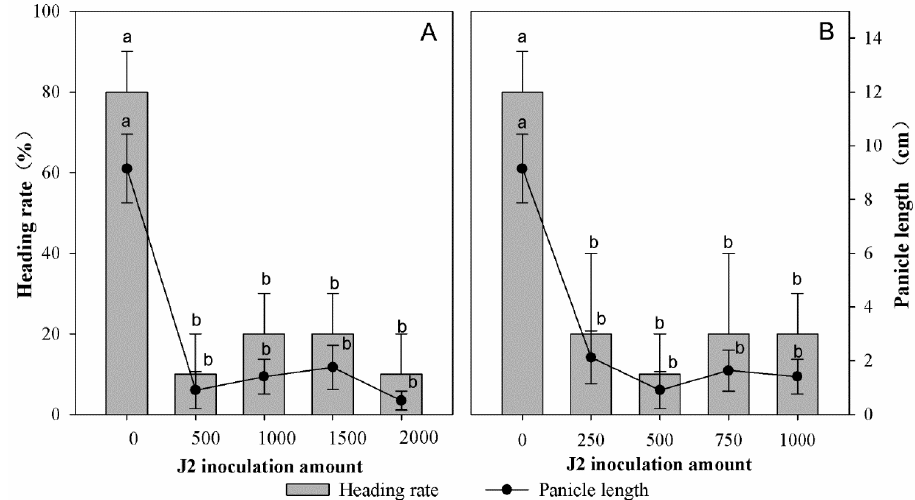
Figure 1. Effect of different inoculum densities of M. graminicola J2 on panicle development of rice. ( A ): heading rates and panicle lengths of rice in the first experiment; ( B ): heading rates and panicle lengths of rice in the second experiment. Note: different lowercase letters on the same date indicate significant difference at p < 0.05 level according to LSD.